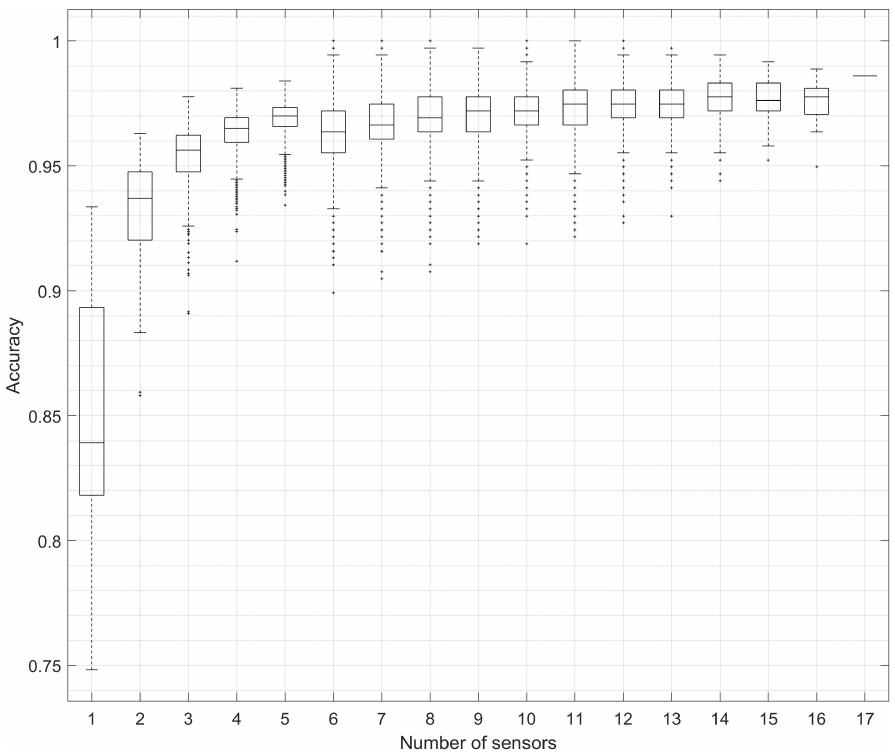
Figure 3. Box plot presenting the SVM classifier accuracy for each sensor configuration, single to 17-sensor combinations. Note the vertical axis does not start from zero to aid readability. Table 9. Classifier (SVM) accuracy for each number of sensor combinations. 95% Confidence